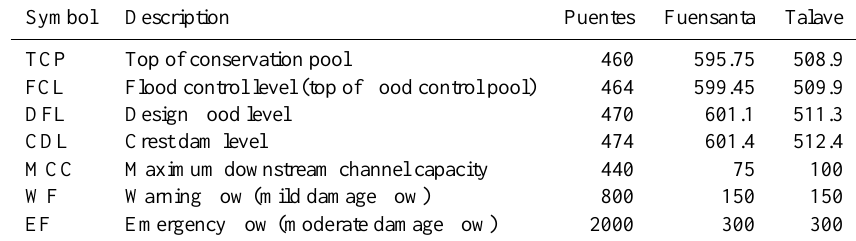
Table 2. Abbreviations used to refer to flows and volume (levels), which are characteristic of the reservoir and the